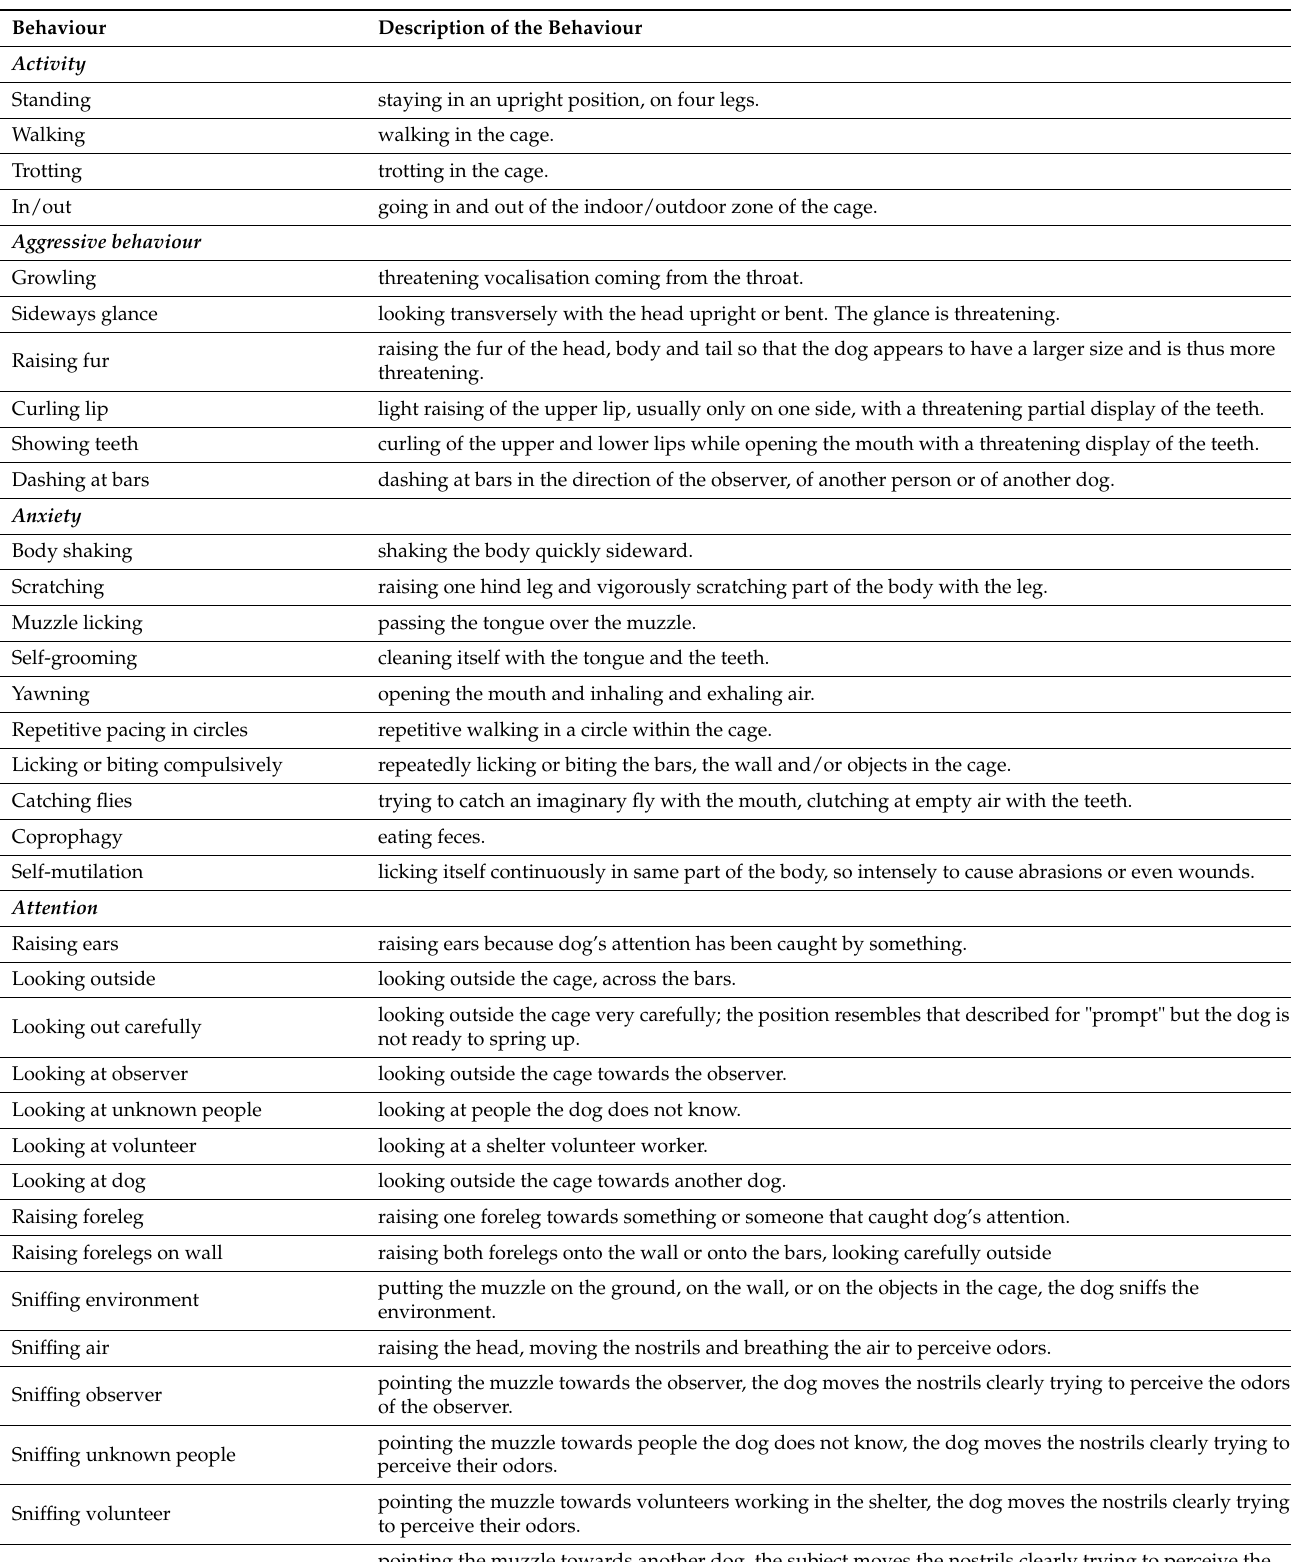
Table A1. The Ethogram Utilised in This Study for Behavioural Observations during the Pre-Adoption Phase (De Palma et al. 2005). Behaviour Description of the